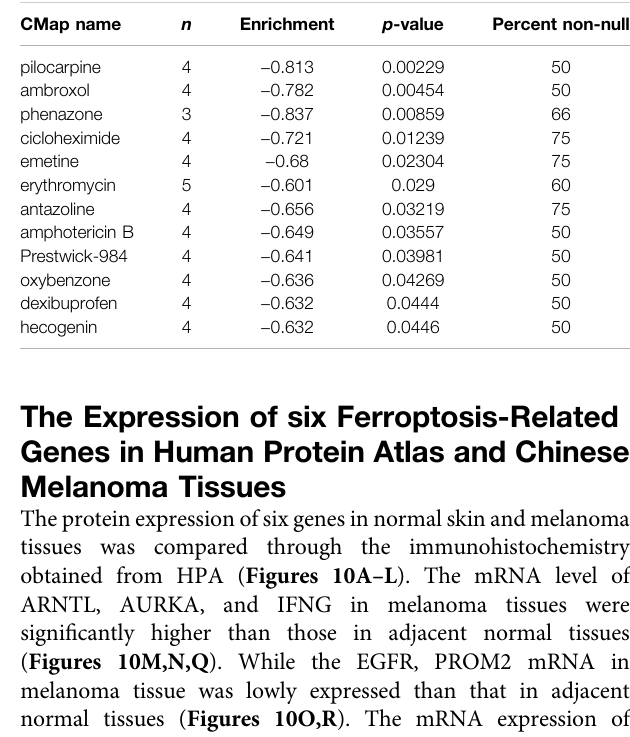
TABLE 1 | Ferroptosis-related potential small-molecules for melanoma